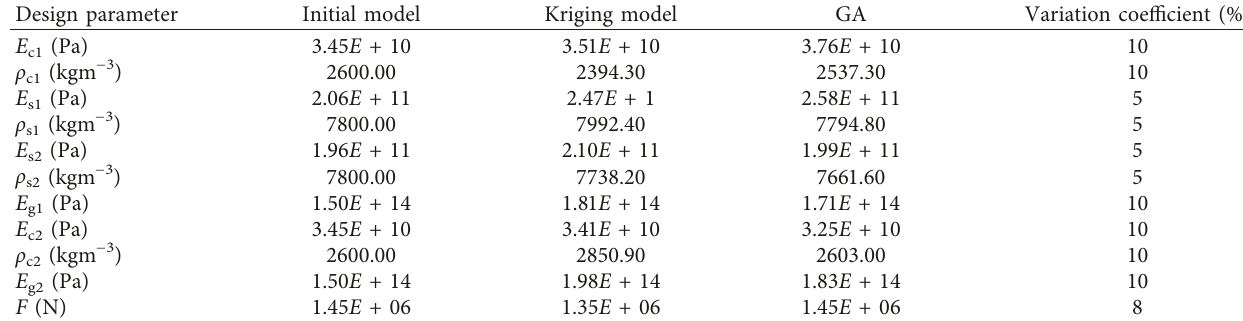
Table 3: Updated results of design parameters.